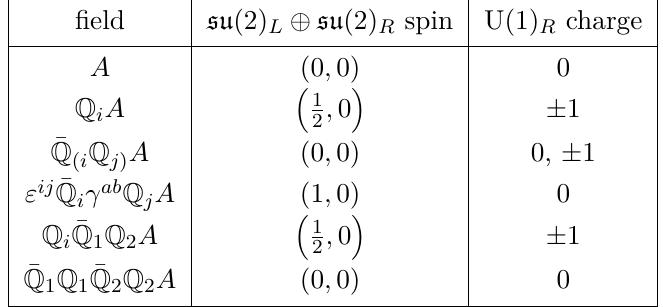
Table 1 . The field content of the chiral multiplet, with all operators being complex. It contains 16 + 16 independent real operators, where operators of spin ( j (2 j + 1)(2 j + 1) L R